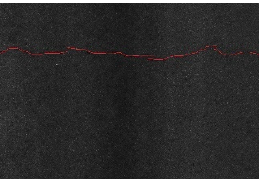
Figure 20. Road multi-function detection vehicle.